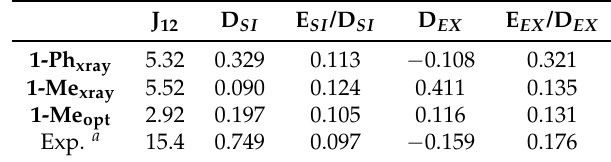
Table 1. Calculated single ion and anisotropic exchange anisotropy tensors.